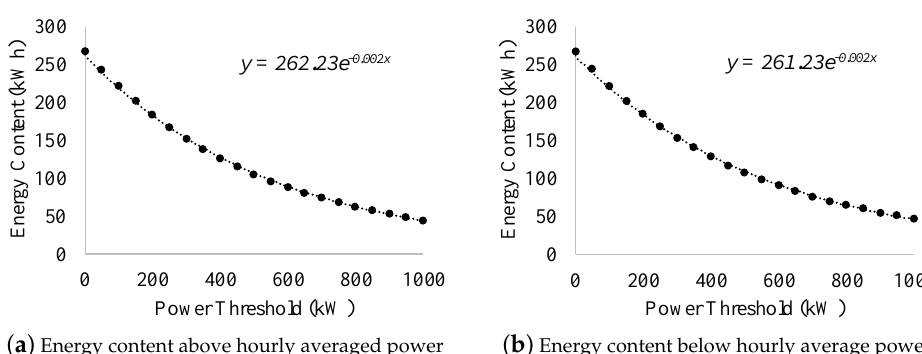
Figure 15. Energy above and below the averaged hourly required power vs. power